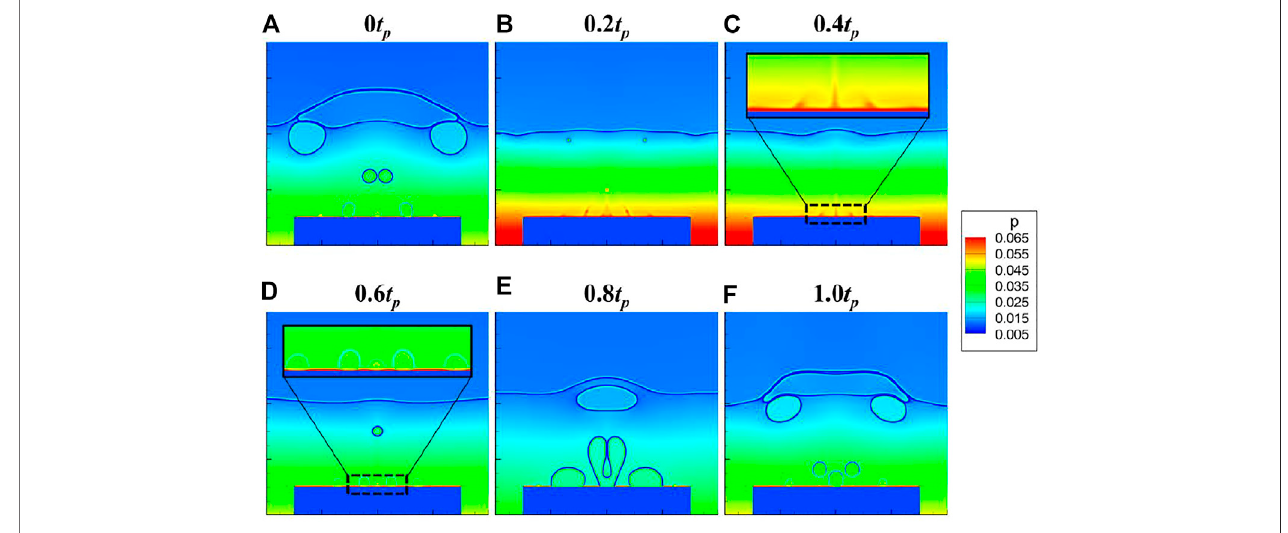
FIGURE 11 | Pressure fi eld at the convection regime under heaving conditions.